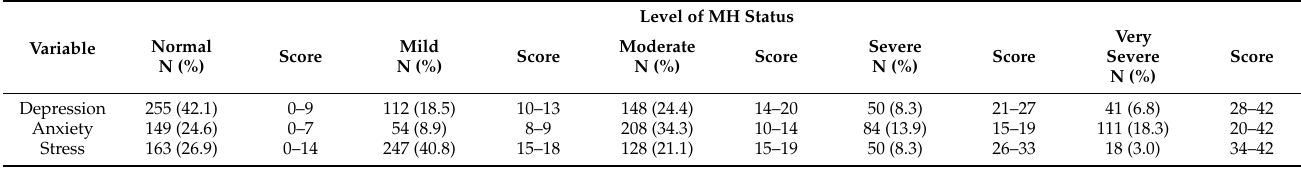
Table 2. The score and level of college students’ MH status (n =